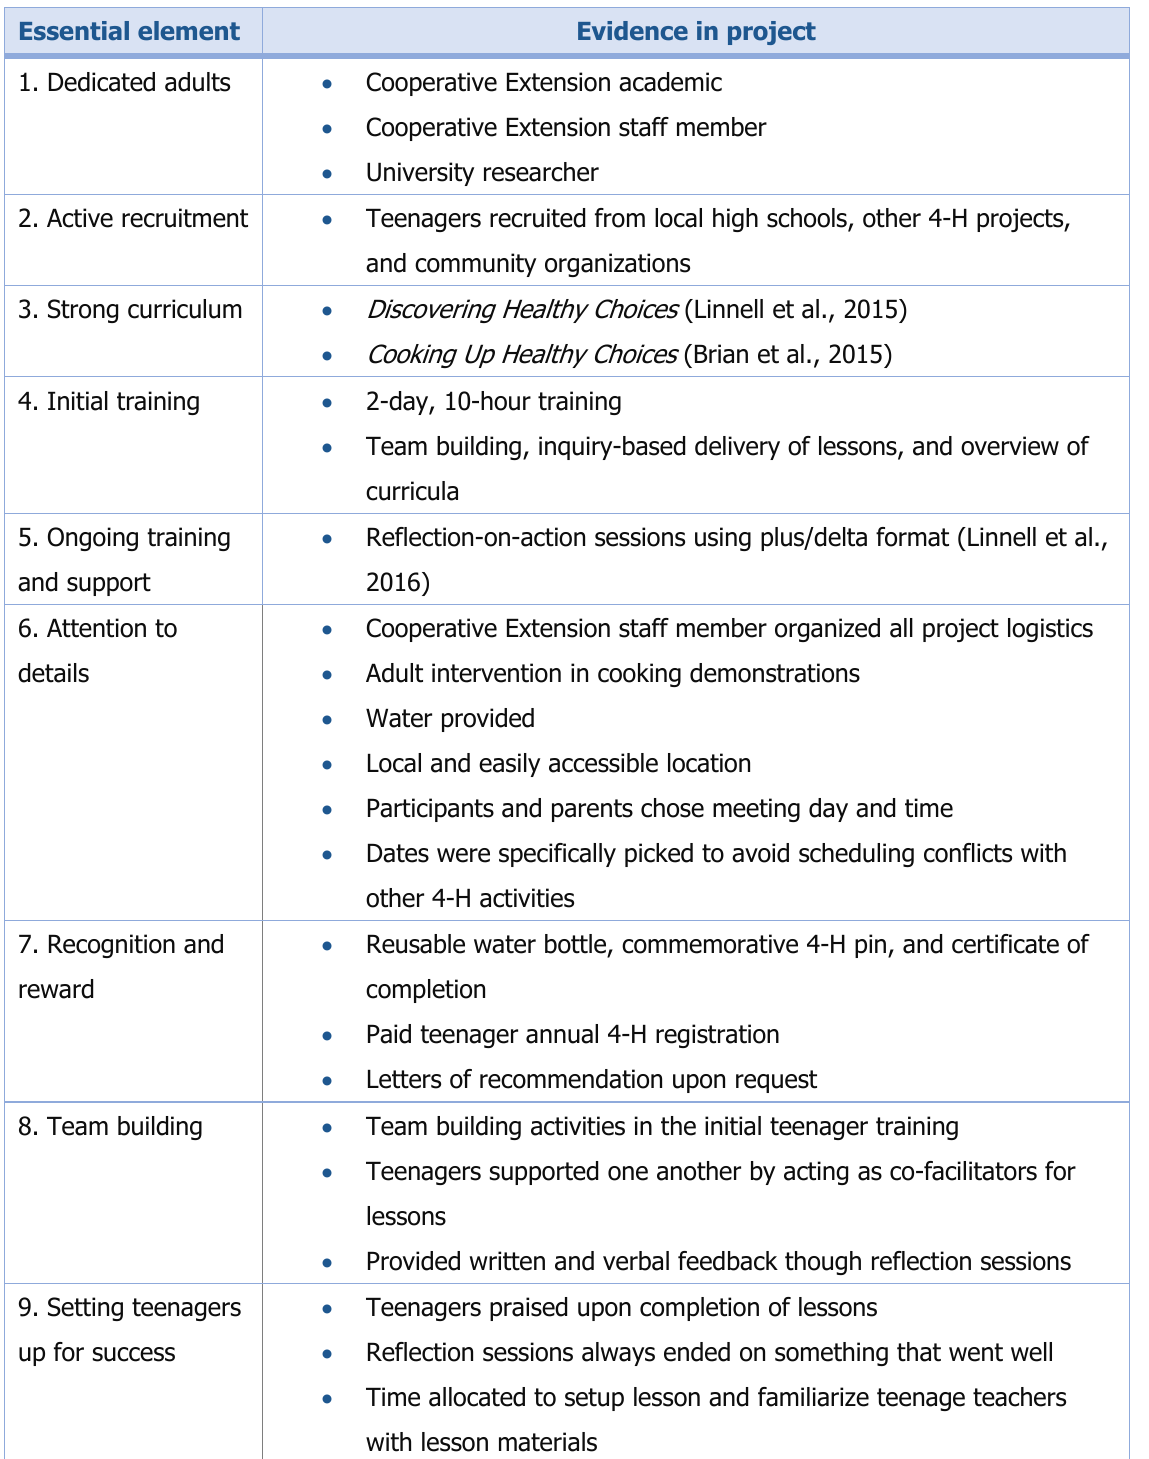
Table 2. Project Alignment With 10 Essential Elements for Successful Teenagers-as- Teachers Programs (Lee & Murdock, 2001) Essential